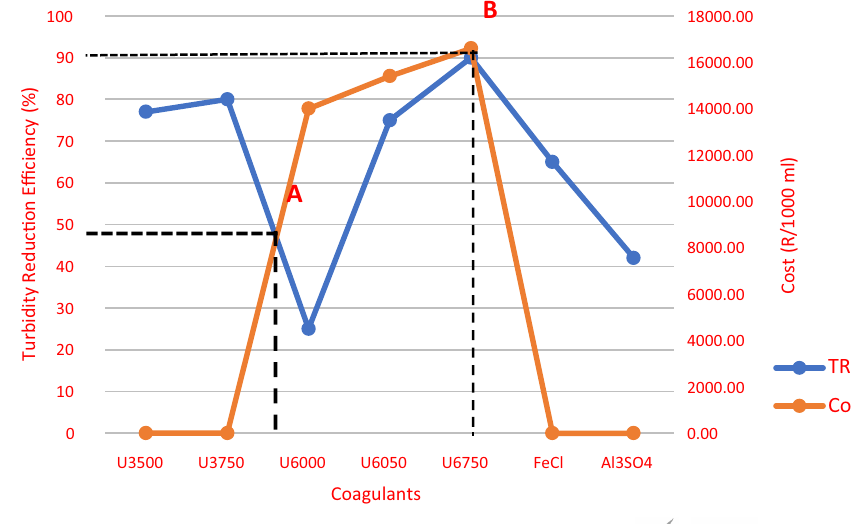
Fig. 6 A Cost/Efficiency plot of the